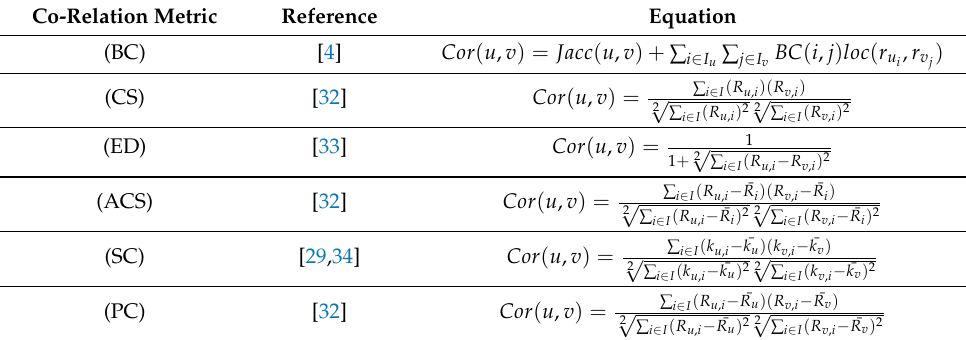
Table 3. Co-relation Metric.